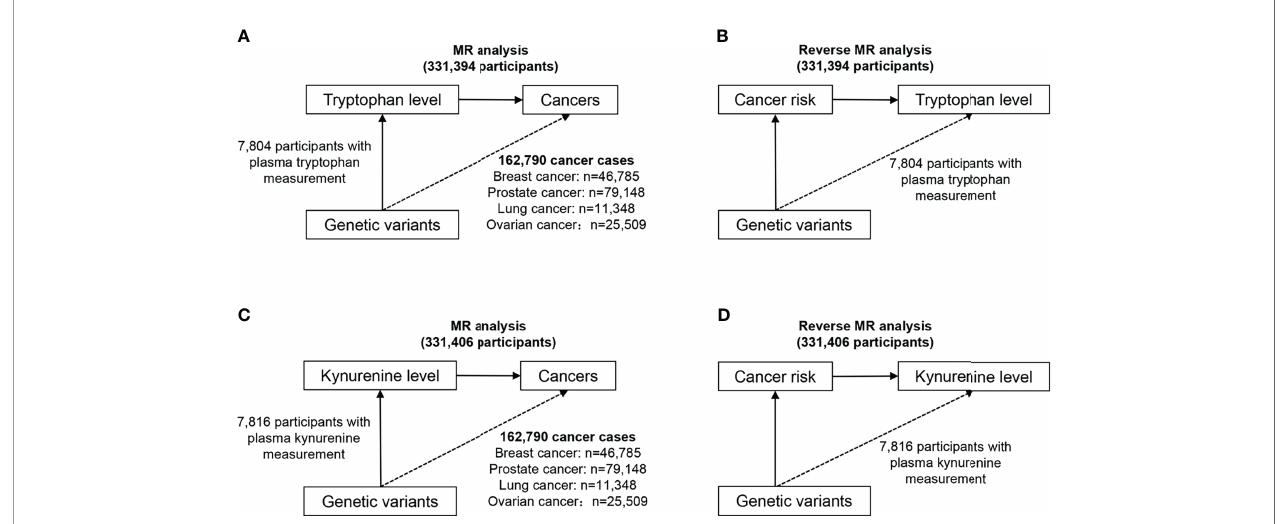
FIGURE 1 | Study design overview of the bidirectional MR analysis. (A) Design of the MR analysis of the causal association of circulating tryptophan levels with the risk of site-speci fi c cancers (upper left). (B) Design of the reverse MR analysis of the causal association of site-speci fi c cancers with circulating tryptophan levels (upper right). (C) Design of the MR analysis of the causal association of circulating kynurenine levels with the risk of site-speci fi c cancers (lower left). (D) Design of the reverse MR analysis of the causal association of site-speci fi c cancers with circulating kynurenine levels (lower